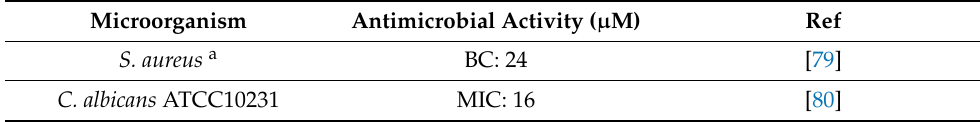
Table 5. Antimicrobial activity against selected microorganisms of peptide temporin G.